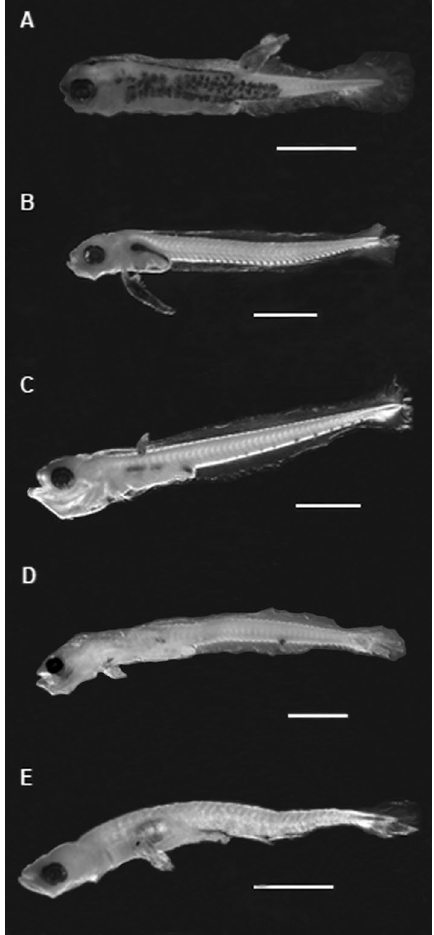
Figure 2. Photography of parasitized fish larvae species recorded in area of study. ( A ) Gobiesox marmoratus , ( B ) Helcogrammoides cunninghami , ( C ) Auchenionchus crinitus , ( D ) Myxodes sp., ( E ) Ophiogobius jenynsi